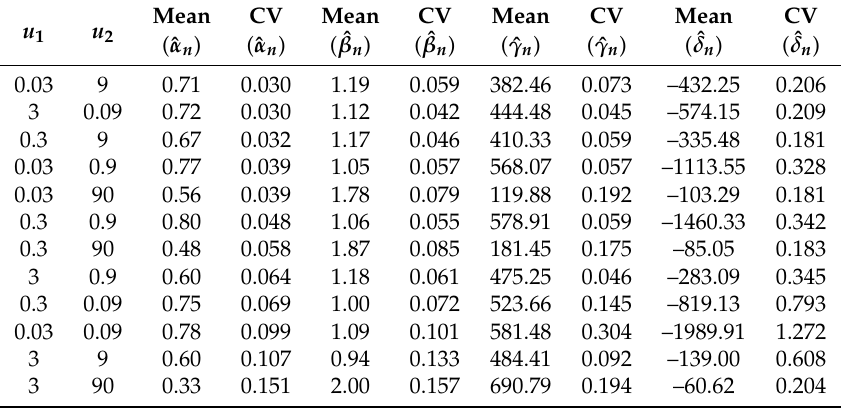
Table 6. Reduced values’ cumulant estimates for data of claims ( n = 2802).